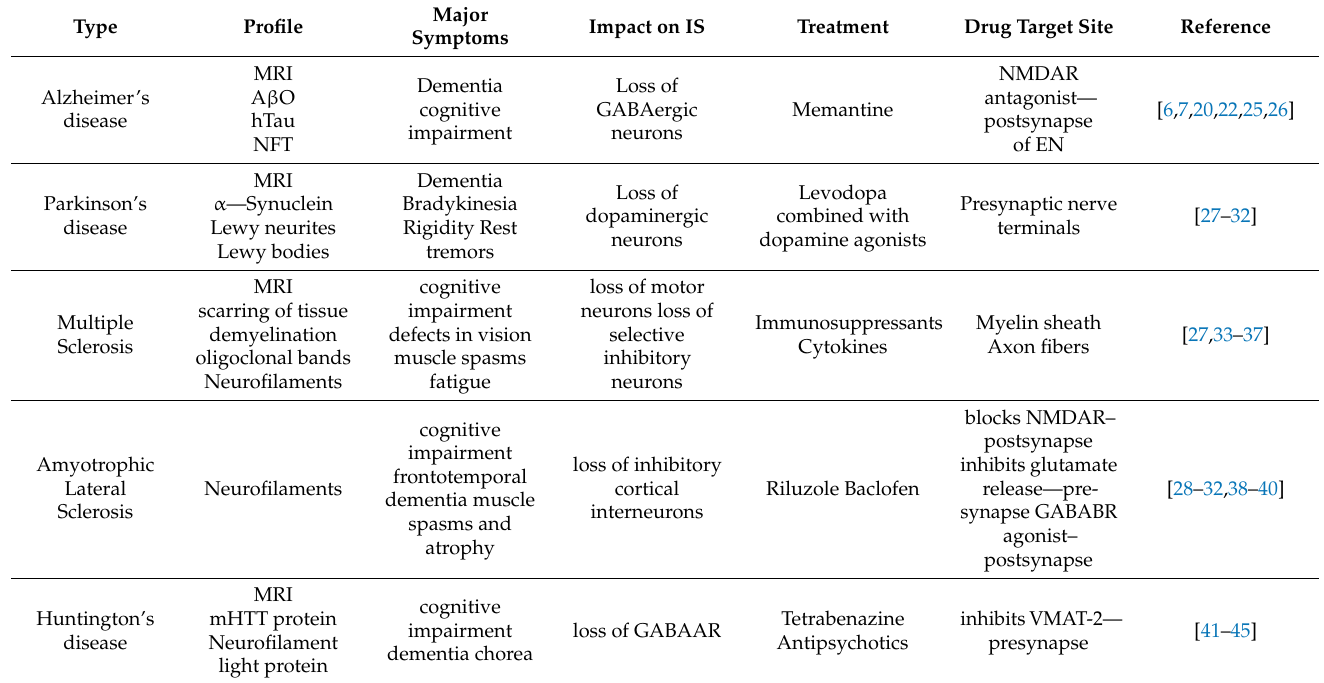
Table 1. The most common neurodegenerative diseases and their specific effect on inhibitory synapses (IS). The current treatment options and drugs mentioned here are used only to alleviate the symptoms in order to halt the progression of the